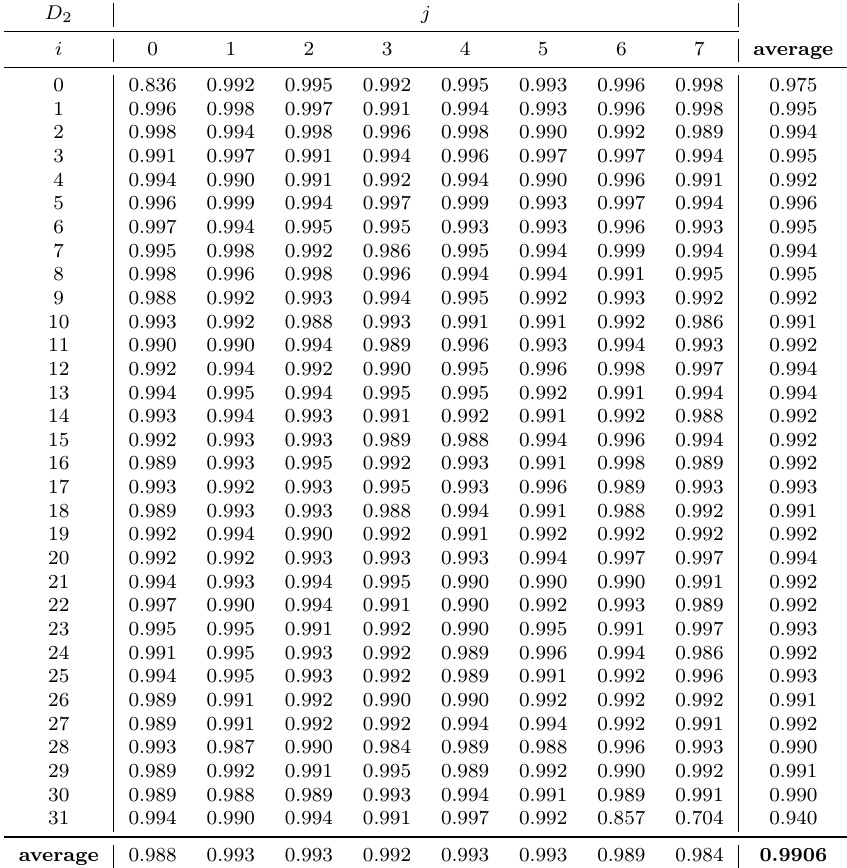
Table 16: Empirical probability to recover the message bit m [8 i + j ] from a single trace using poly_A2A() . Average results for 1K traces from device D 2 . D